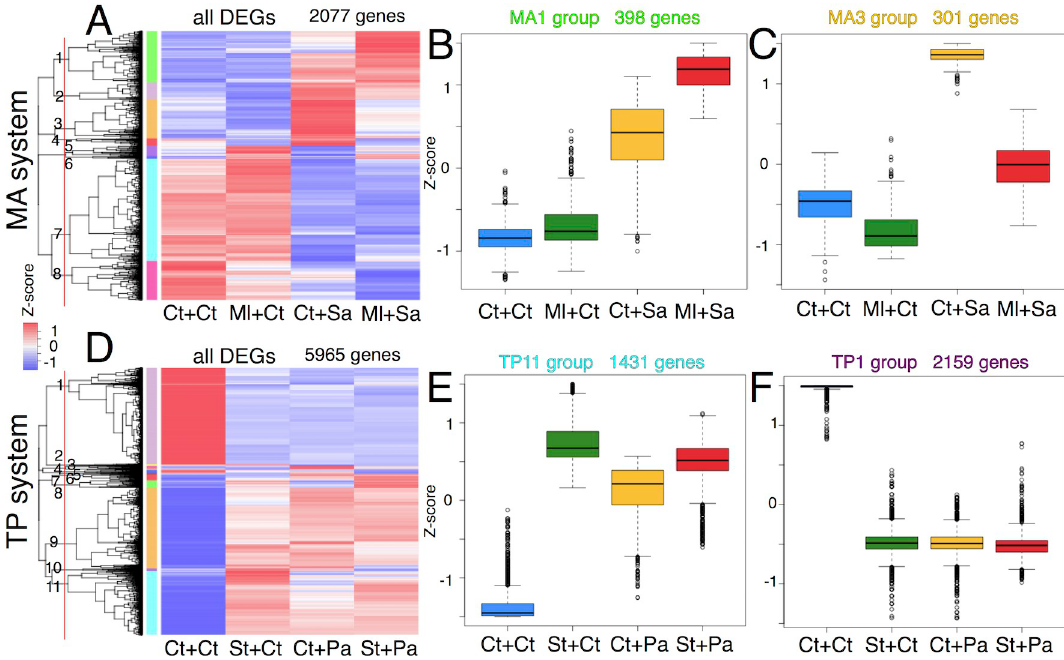
Fig 4. Clustering analysis of DEGs. (A, D) Heat maps of z-scores for DEGs of MA (A) and TP (D) systems. Genes (rows) were ordered by clustering analysis. Red lines represent thresholds on dendrograms to divide the DEGs into the clustering groups (numbers and color bars). (B, C, E, F) Box plots of z-scores of DEGs categorized to MA1 (B), MA3 (C), TP11 (E), and TP1 (F) groups. The numbers of genes categorized to these groups are indicated in graphs.